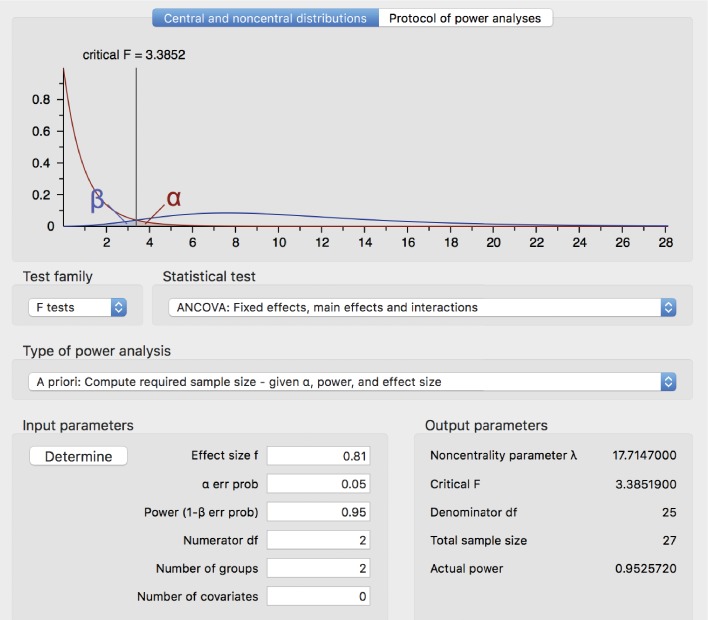
Power analysis to compute sample size.Conducted using G*Power software version 3.1, based on the inclusion of two groups, an alpha value of 0.05, and an effect size of 0.81 (Cohen’s d reported by Majid et al., 2015) in a study training voluntary modulation of MEP amplitude, for an F-test comparing effect of whether the MEP was cued or uncued). As our core findings are communicated using F-tests following mixed effects models, we selected to perform this power analysis based on the F-tests family.